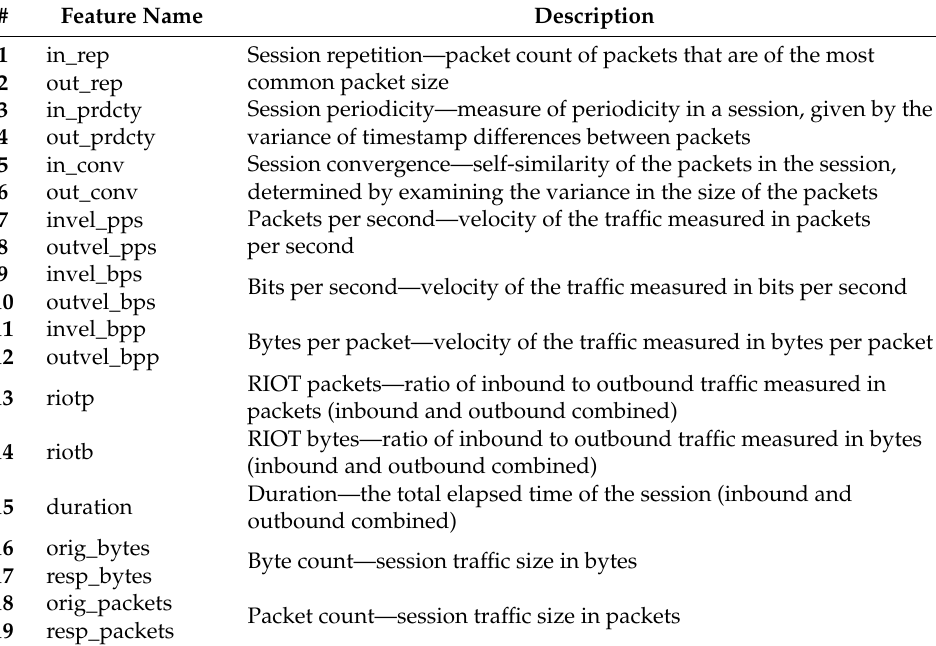
Table 2. Description of features present in the